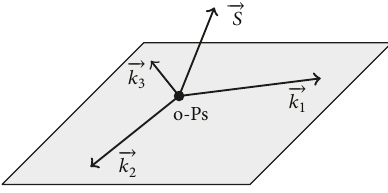
Figure 2: Vectors describing the final state of an o-Ps 󳨀→ 3 𝛾 annihi- 󳨀→ 𝑆 denotes orthopositronium lation in the o-Ps frame of reference. 󳨀→ 𝑘 spin and 1,2,3 are the momentum vectors of the annihilation photons, lying in a single plane. The operator defined in (4) is a measure of angular correlation between the positronium spin and the decay plane normal